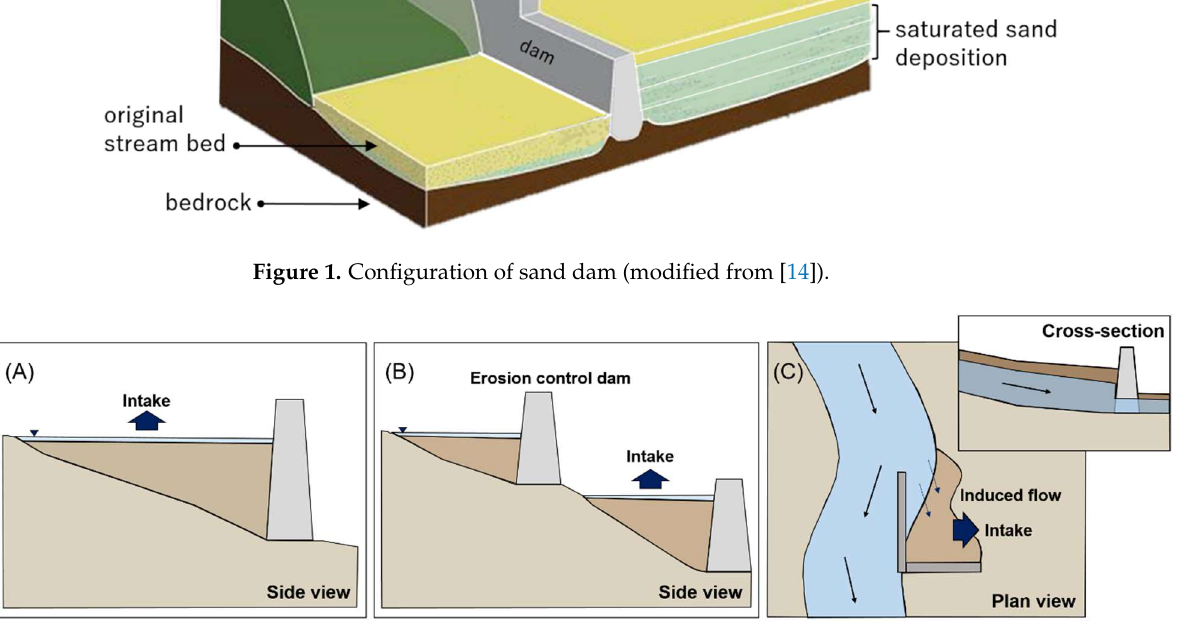
Figure 2. Types of sand dams: ( A ) Stand-alone, ( B ) Multi-stage, ( C ) By-pass (modified from Kim et al. [15]).